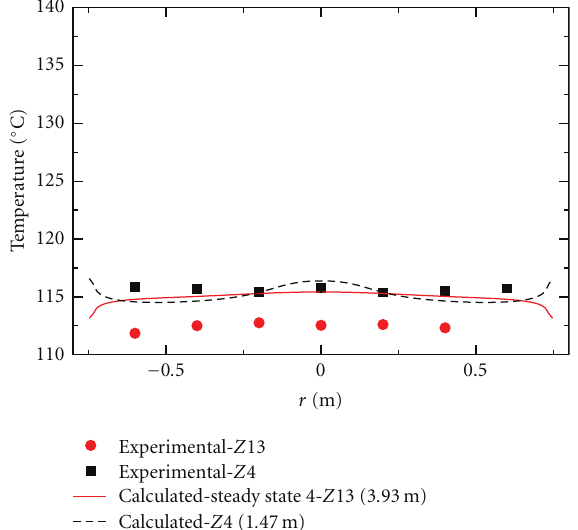
Figure 16: Radial profile of the gas temperature at Z 4 = 1 . 47m and Z 13 = 3 . 93 m: steady state 4.